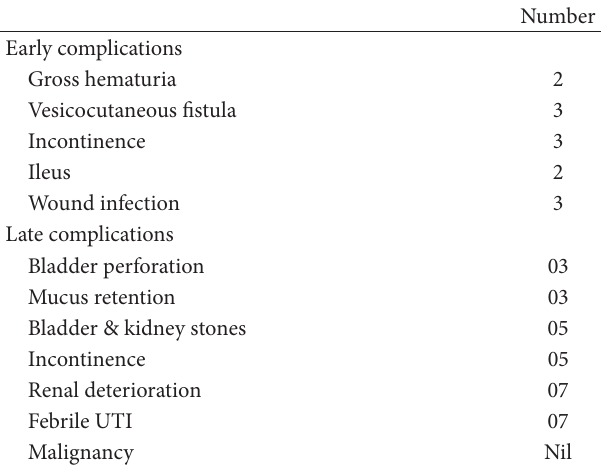
Table 7: Early and late